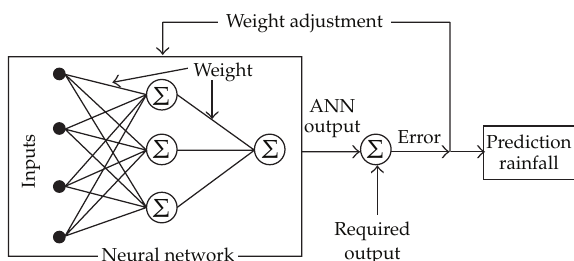
Figure 2: ANN architecture with back-propagation